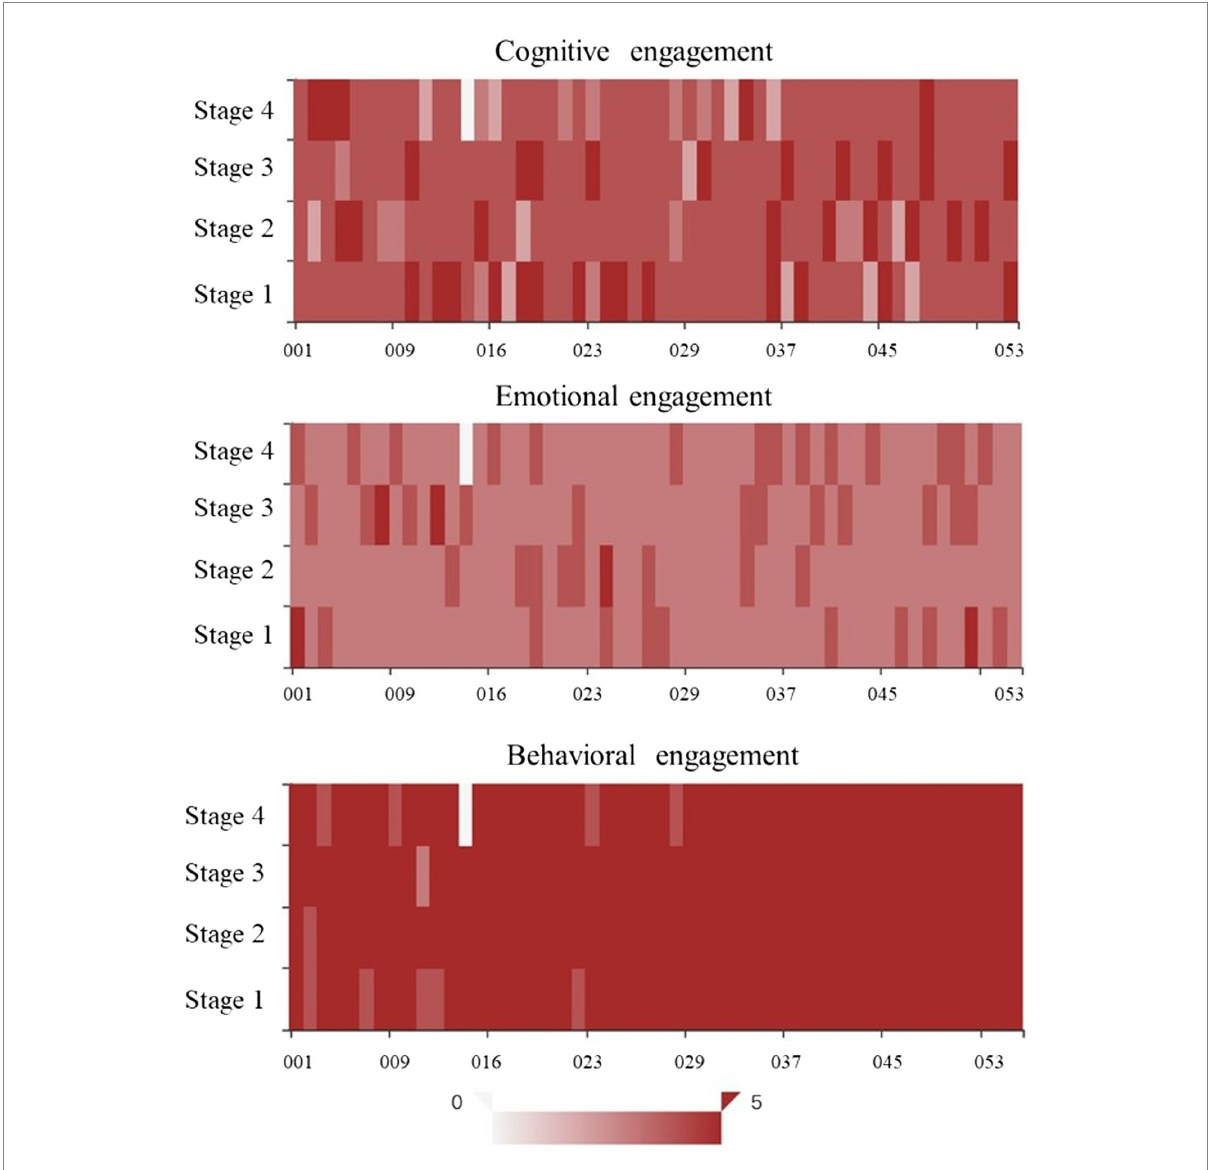
FIGURE 3 Thermal distribution map of multi-modal fusion characteristic